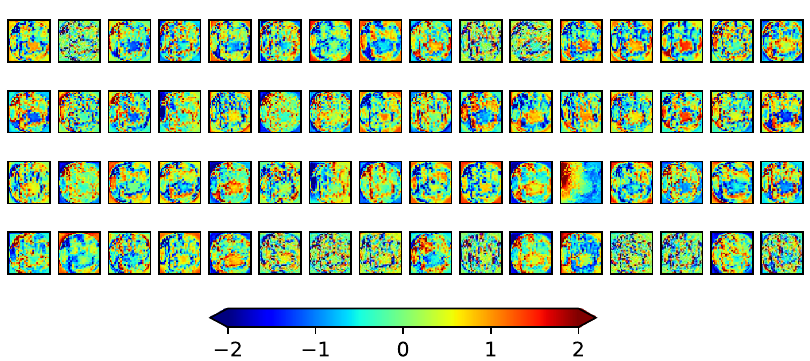
Figure A4. Feature maps with a size of 32 × 32 pixels that are output from the last convolution layer of the residual block (A3) shown in Figure 9, for the case shown in Figure A2. All 64 feature maps are shown. Each image shows the normalized signal of the feature map with a mean of 0 and standard deviation of 1.